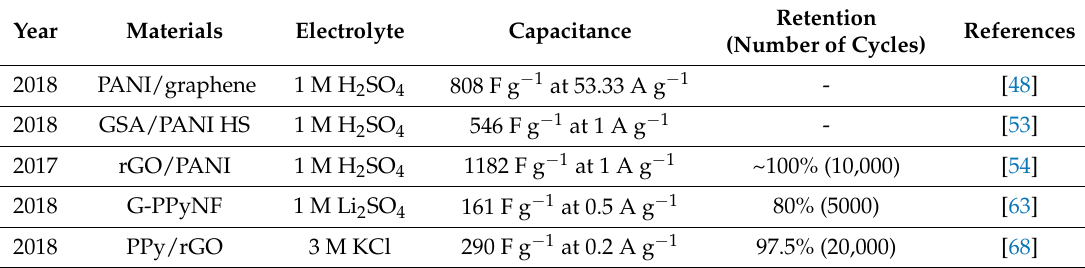
Table 2. Performance of CPs/graphene composite